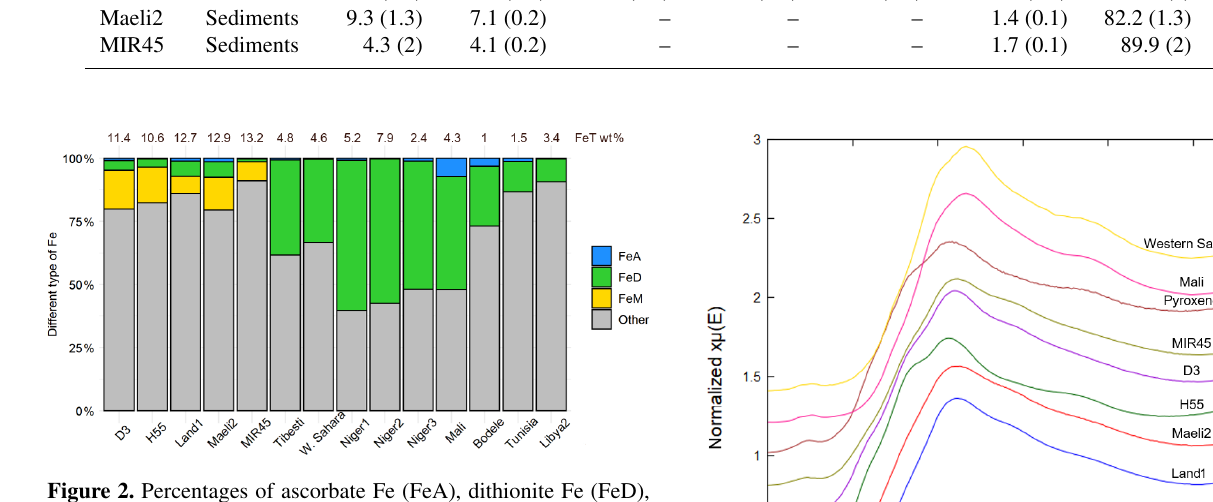
Figure 2. Percentages of ascorbate Fe (FeA), dithionite Fe (FeD), magnetite Fe (FeM) and other Fe to the total Fe (FeT) in Icelandic dust PM 10 samples (this study) and African dust (Shi et al., 2011b). The data uncertainty was estimated using the error propagation for- mula: 12%–22% for FeA, 11%–16% for FeD, 12%–19% for FeM, and ∼ 11% for FeT. The original data are reported in Table S3 of the Supplement. Note that FeM was not measured in Shi et al. (2011b), but it is expected to be negligible in northern African